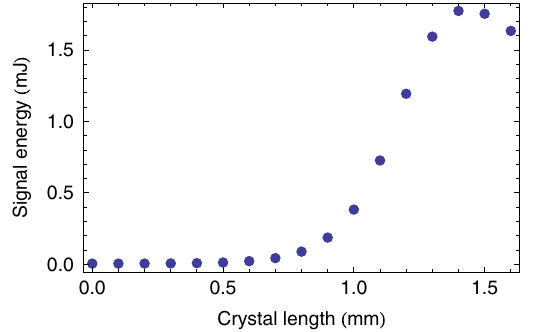
FIG. 10. An improved temporal profile calculation for the signal (black) and residual pump (red) after the 1.4 mm long second optical parametric amplifier by inclusion of group ve- locity dispersion reveals the temporal walk-off between the pulses and a small shortening and distortion of the amplified signal pulse.